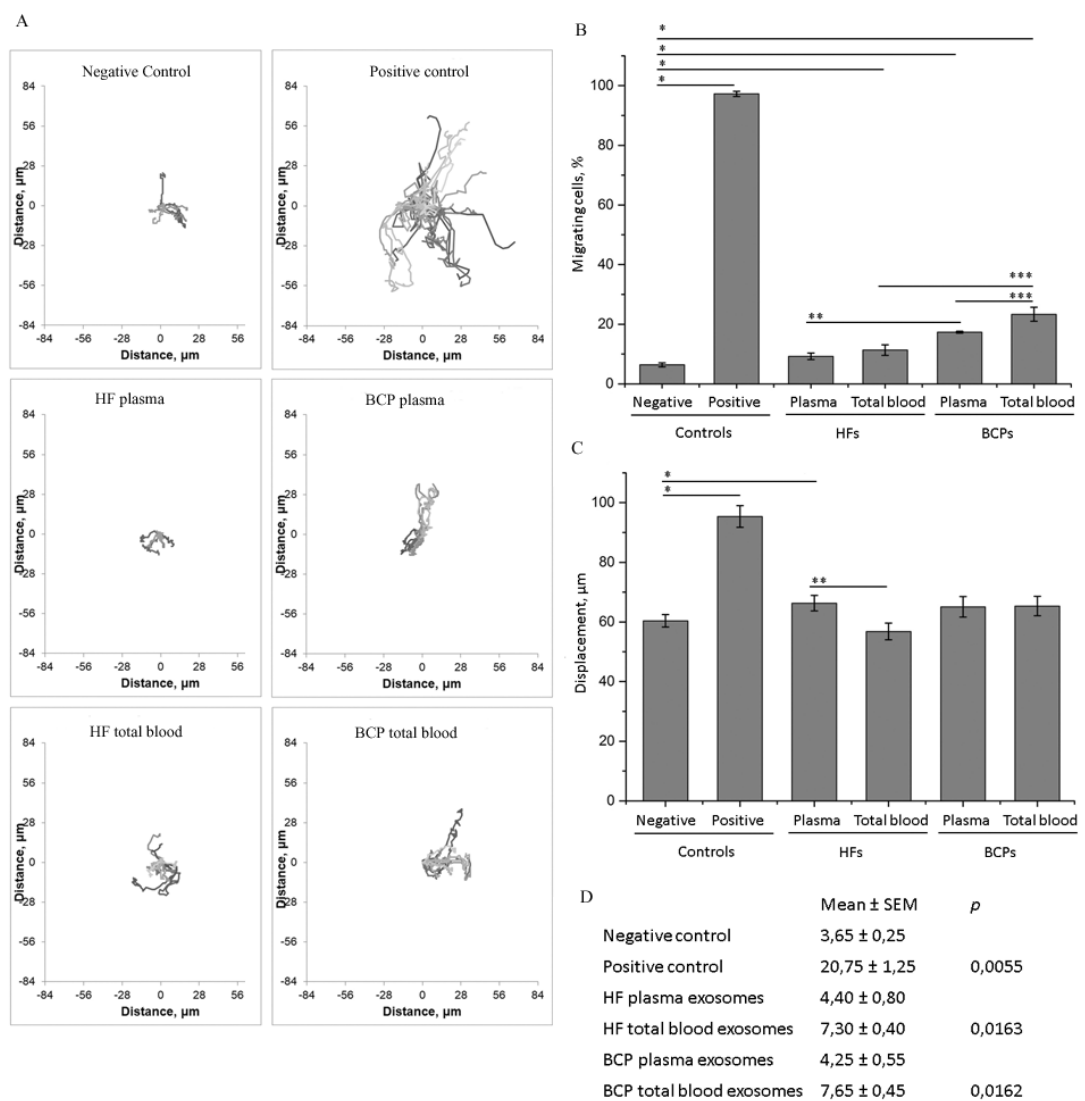
Figure 4. The effects of plasma and total blood exosomes on MCF10A cell migration and proliferation. Results of three independent experiments are presented as mean ± SEM, * p < 0.05 vs. negative control, ** p < 0.05 vs. exosomes from plasma of HFs, *** p < 0.05 vs. exosomes from total blood of BCPs. Trajectory plots of single-cell migration experiments of MCF10A in the presence or absence of exosomes ( A ), the proportion of motile cells ( B ), displacement over 15 h ( C ), and mitotic activity (percentage of mitosis events during 15 h of observation) ( D ).